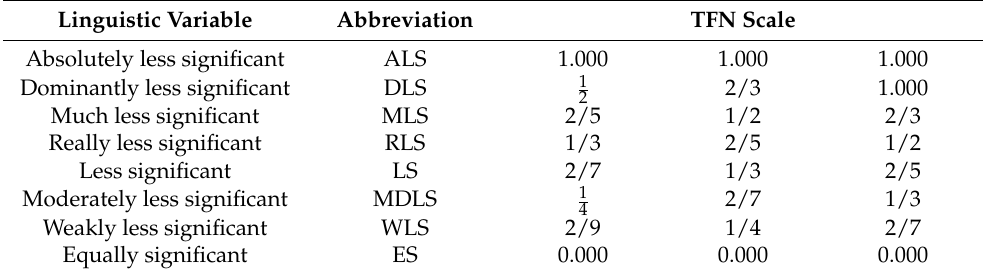
Table 1. New linguistics and the TFN scale for the evaluation of the criteria in the improved fuzzy SWARA (IMF SWARA)